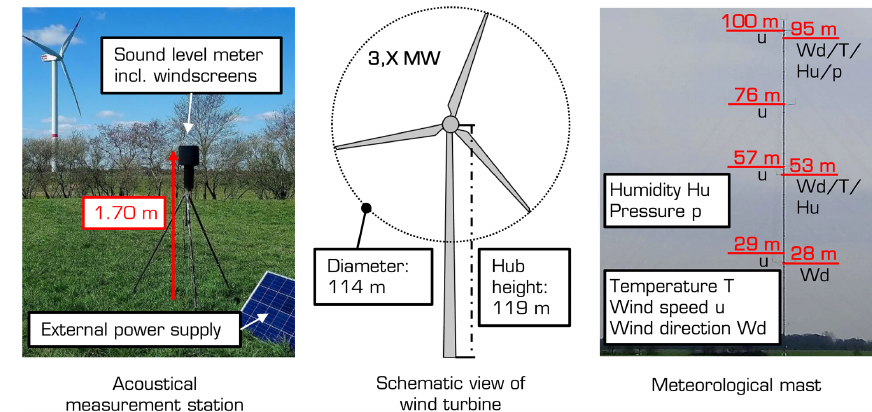
Figure 2. Overview of measurement systems and wind